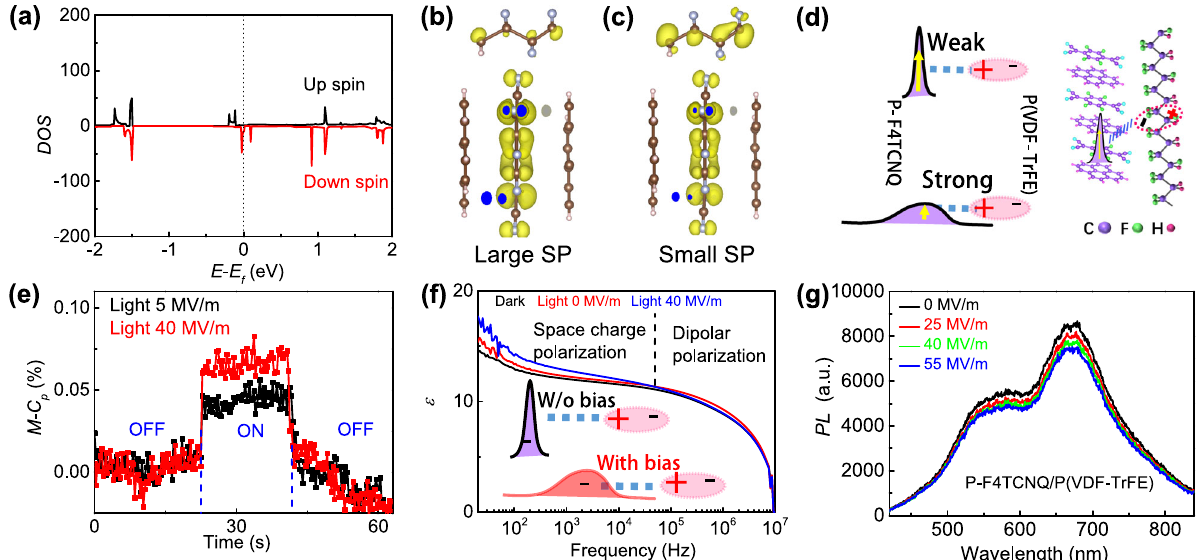
Fig. 2 Theoretical simulation and experiment analysis. a Spin dependence of density of states (DOS) of P-F4TCNQ/P(VDF-TrFE) complexes. Strong b and weak c charge interaction at interface of P-F4TCNQ/P(VDF-TrFE). SP denotes spin polarization in FM. With small spin polarization in FM, the interaction between P-F4TCNQ and P(VDF-TrFE) is stronger. d The diagram of spin – dipole interaction at multiferroic P-F4TCNQ/P (VDF-TrFE) complexes. e Magnetic fi eld dependence of dielectric constant of multiferroic P-F4TCNQ/P(VDF-TrFE) complexes. f Frequency dependence of dielectric constant of multiferroic P-F4TCNQ/P(VDF-TrFE) complexes with/without applying external electric fi eld. g Electric fi eld dependence of photoluminescence of multiferroic P-F4TCNQ/P(VDF-TrFE)